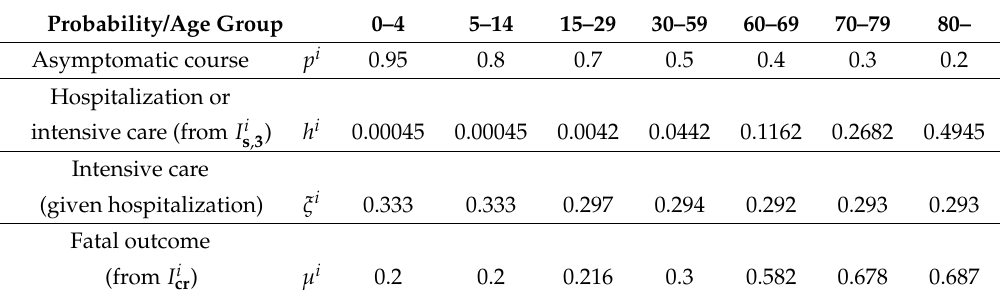
Table 3. Age-dependent epidemiological parameters of